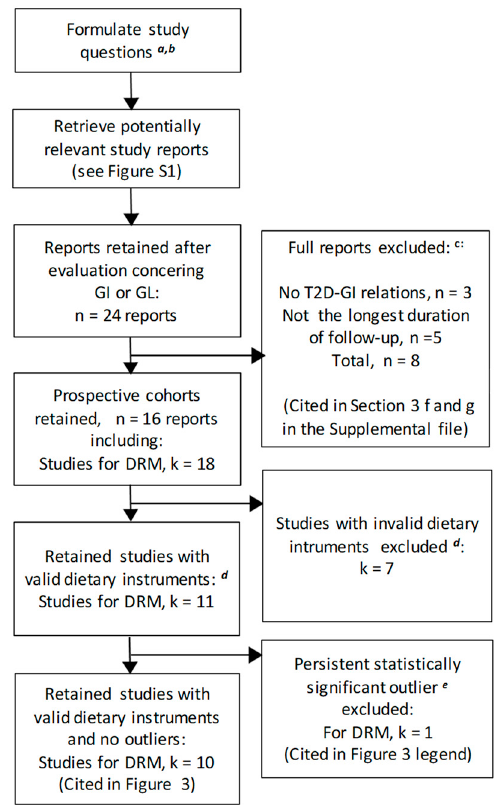
Figure 2. Process of the review and outcomes of the inclusion/exclusion criteria for the T2D–GI risk relation. The literature was searched for prospective cohort studies investigating this relation,